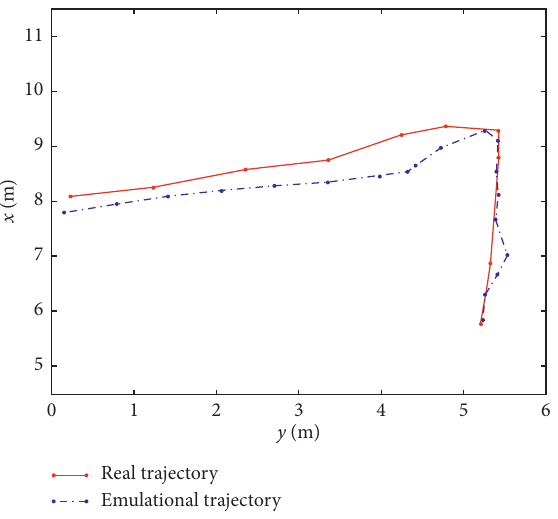
Figure 8: Comparison of passenger 13’s real and emulational